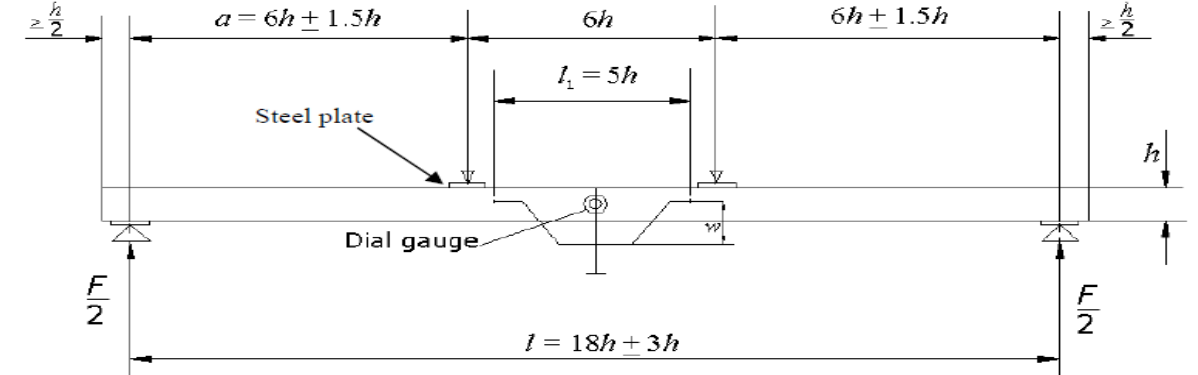
Fig. 4. Setup to measure local modulus of Elasticity in Bending